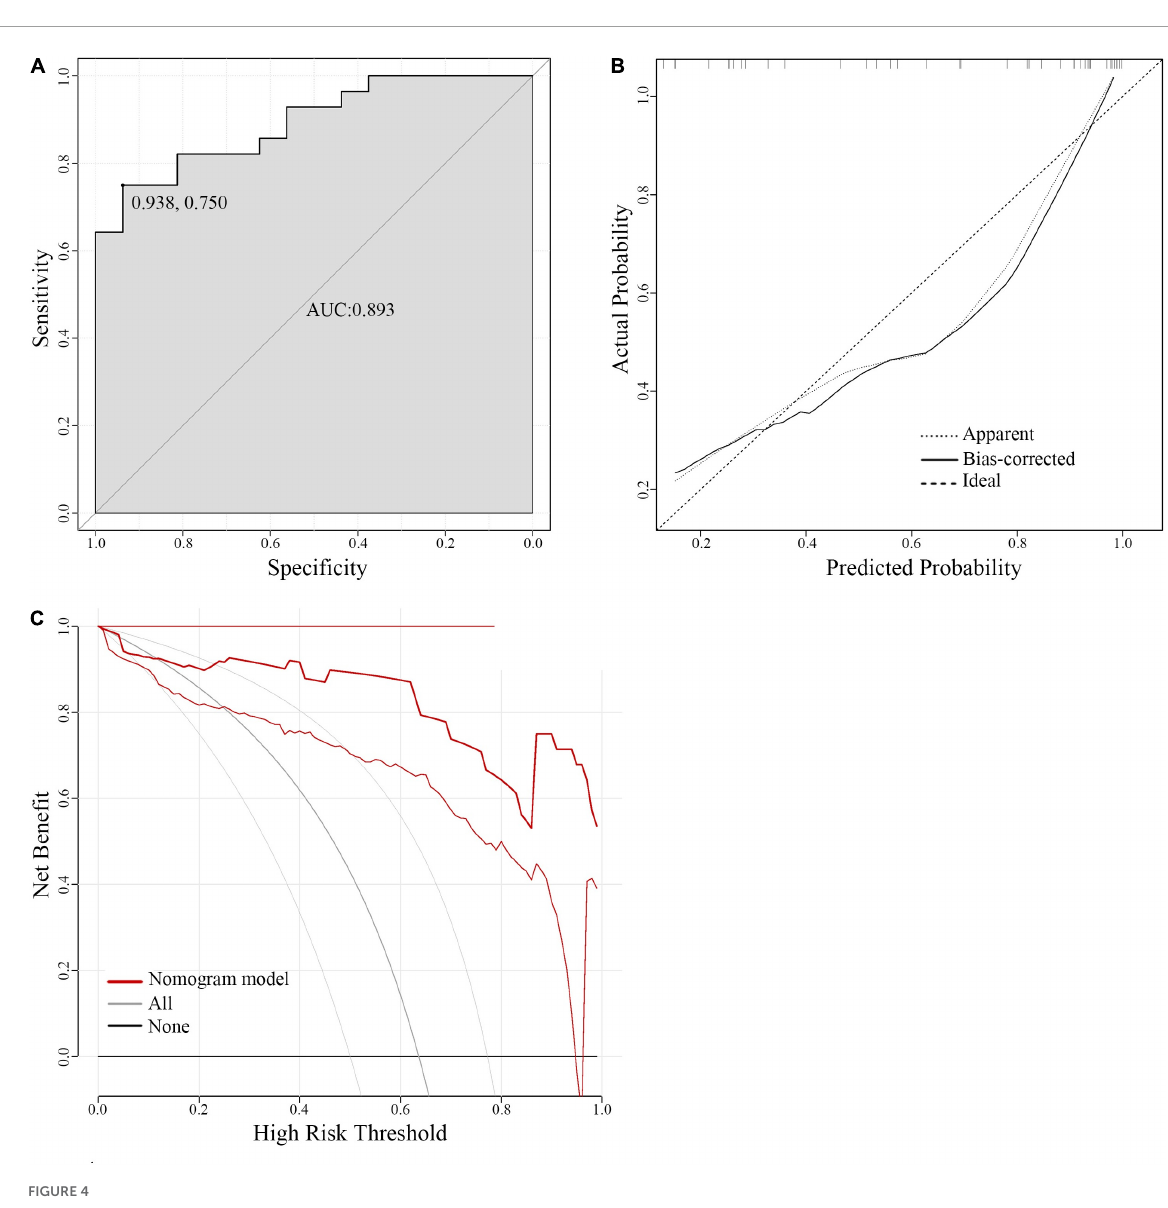
FIGURE4 The calibration plots and decision curve analysis of predictive nomogram in the validation cohort. (A) The ROC curve of the validation cohort. (B) The calibration curve for the validation cohort. (C) DCA of the validation cohort. ROC curve, receiver operating characteristic curve; DCA, decision curve